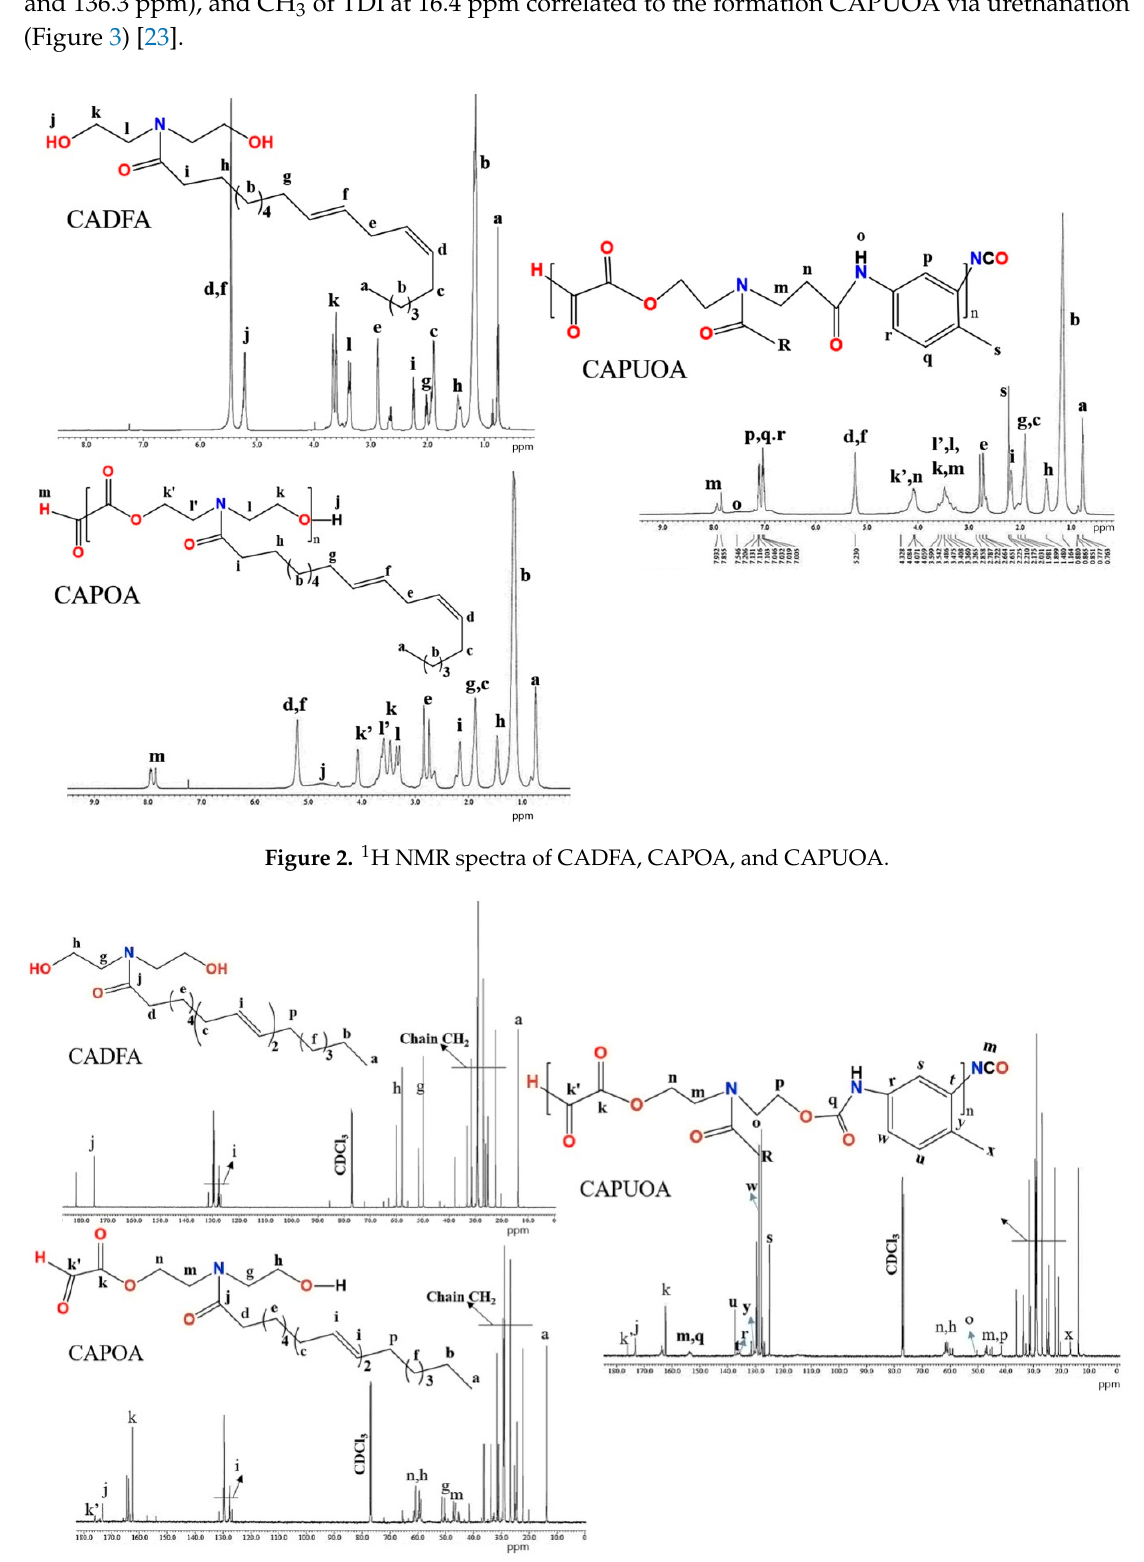
Figure 3. 13 C NMR spectra of CADFA, CAPOA, and CAPUOA.